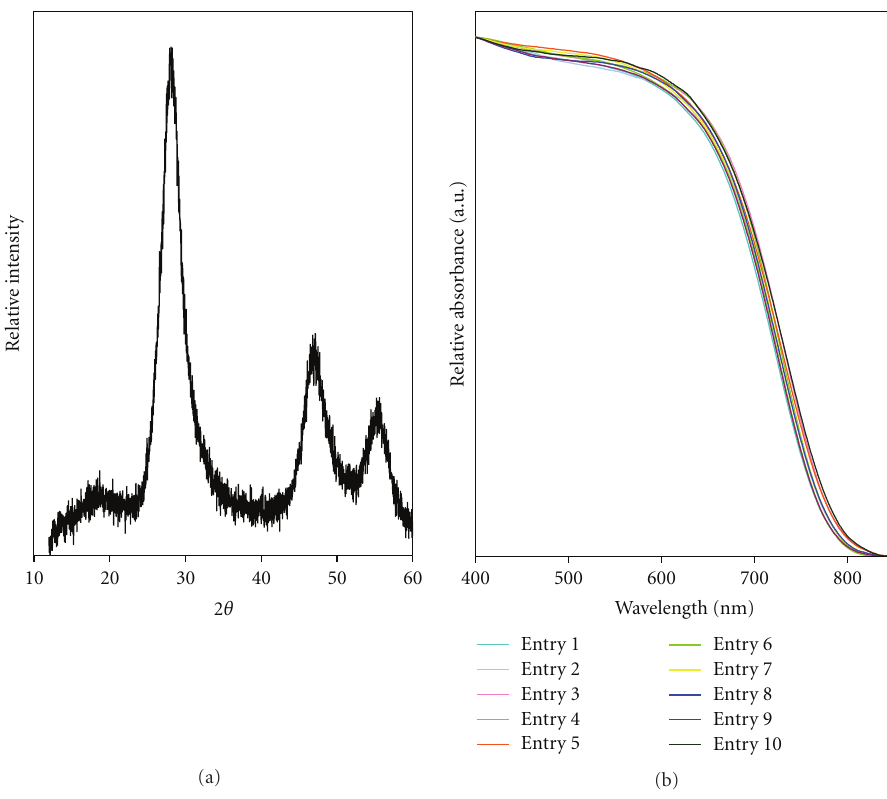
Figure 3: (a) Representative of normalized XRD data of CuIn 0 . 7 Ga 0 . 3 S 2 nanoparticles prepared at 200 ◦ C. (b) Normalized UV-Vis absorption